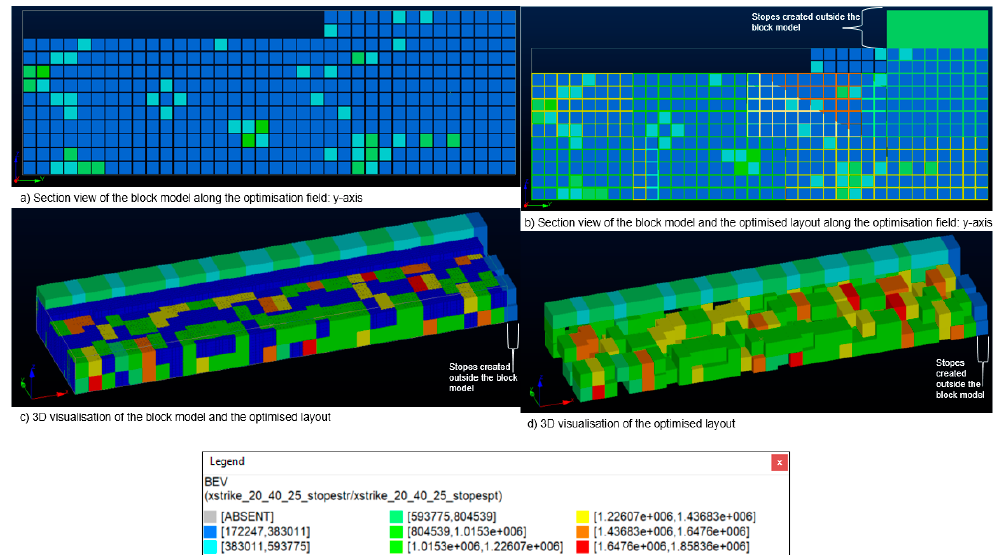
Figure 5. Scenario A: visualisations of the optimum stope layout solution using the MSO with the legend showing SEV in USD. Source: [3].